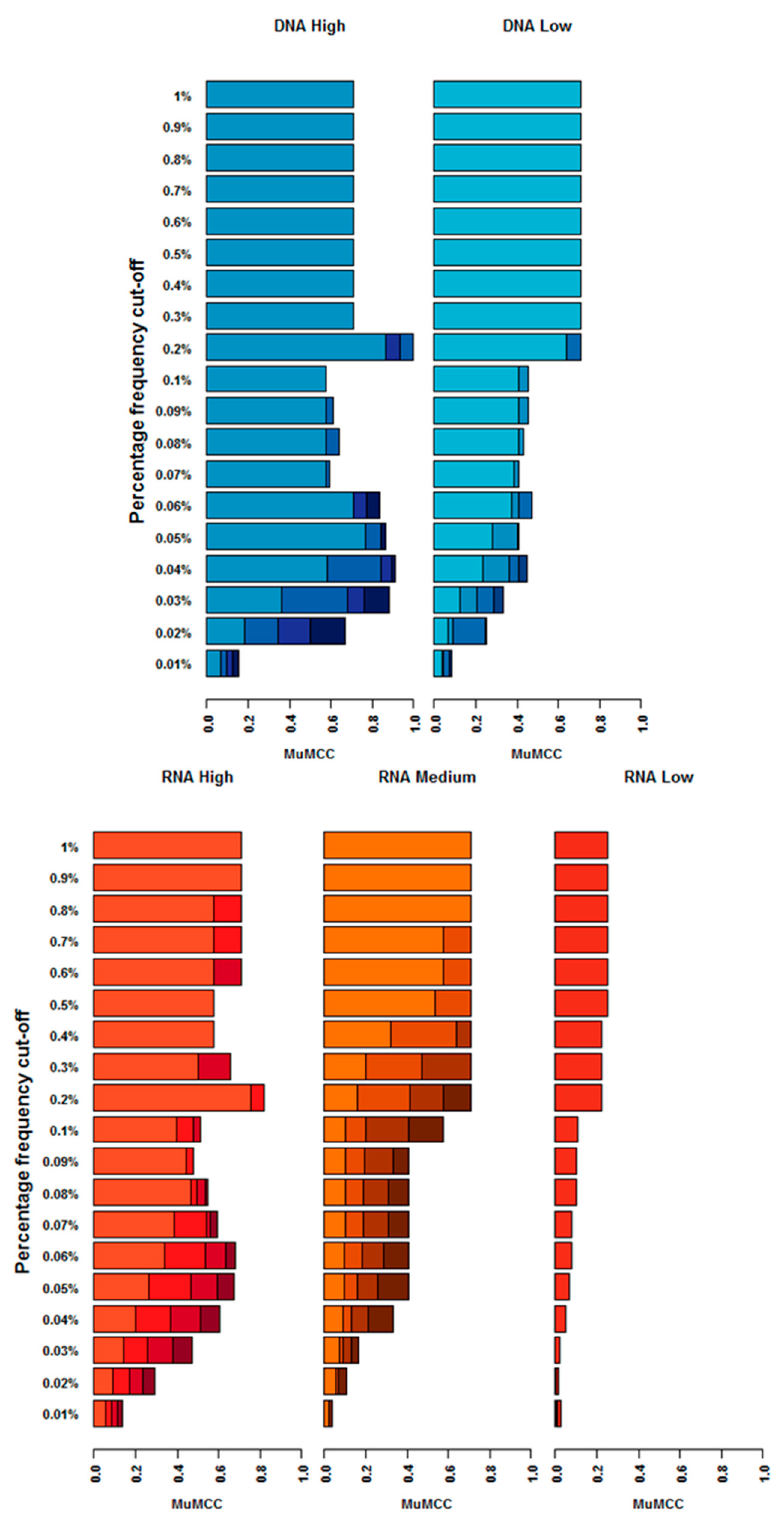
Figure 4. The MuMCC range for each population input for each percentage frequency cut-off parameter tested. Data obtained following alignment using GEM3 and fixed qScore and read length parameters. The data are represented is stacked, with singlet, duplicate, triplicate and quadruplicate replicate combinations for each population type represented by a different shade of colour. Darker colours represent a greater number of replicates with increased MuMCC score benefit.